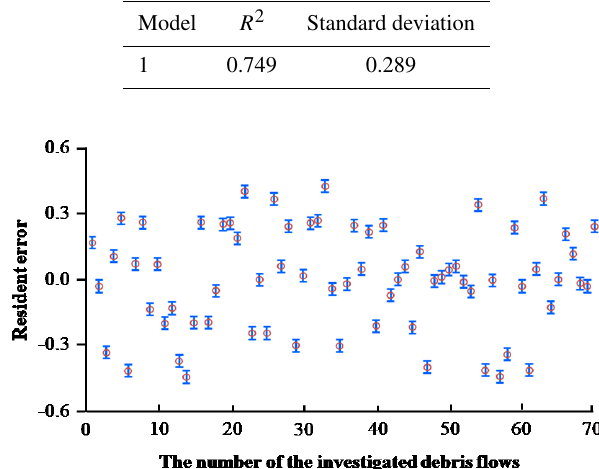
Table 7. Quantitative model eigenvalue.